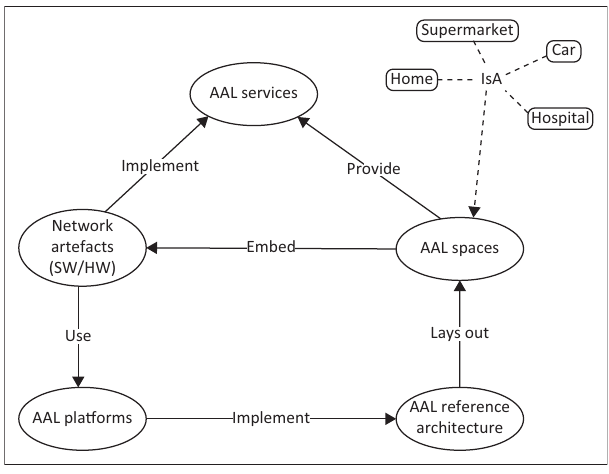
FIGURE 2: The UniversAAL Reference Architecture.